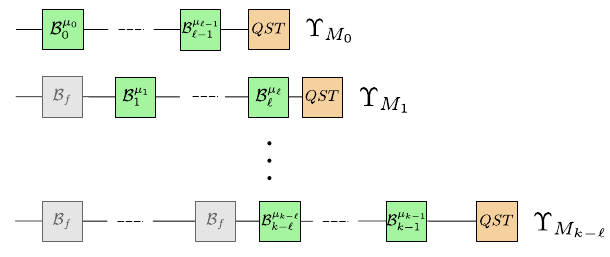
FIG. 7. Circuits to construct a process tensor with conditional , there are k − (cid:2) + 1 Markov order (cid:2) . For a k -step process, ϒ (cid:2) k :0 memory process tensors that need to be constructed—each circuit represents the estimation of each of these, by varying all combi- nations of all indices from i 0 to i (cid:2) − 1 . In the other gate positions, a fixed operation B f is